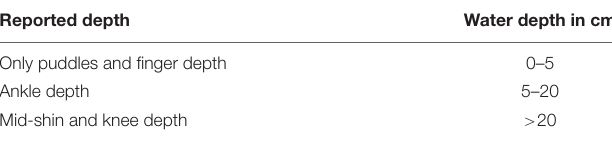
TABLE 2 | Water depth classes used in the model validation. Reported